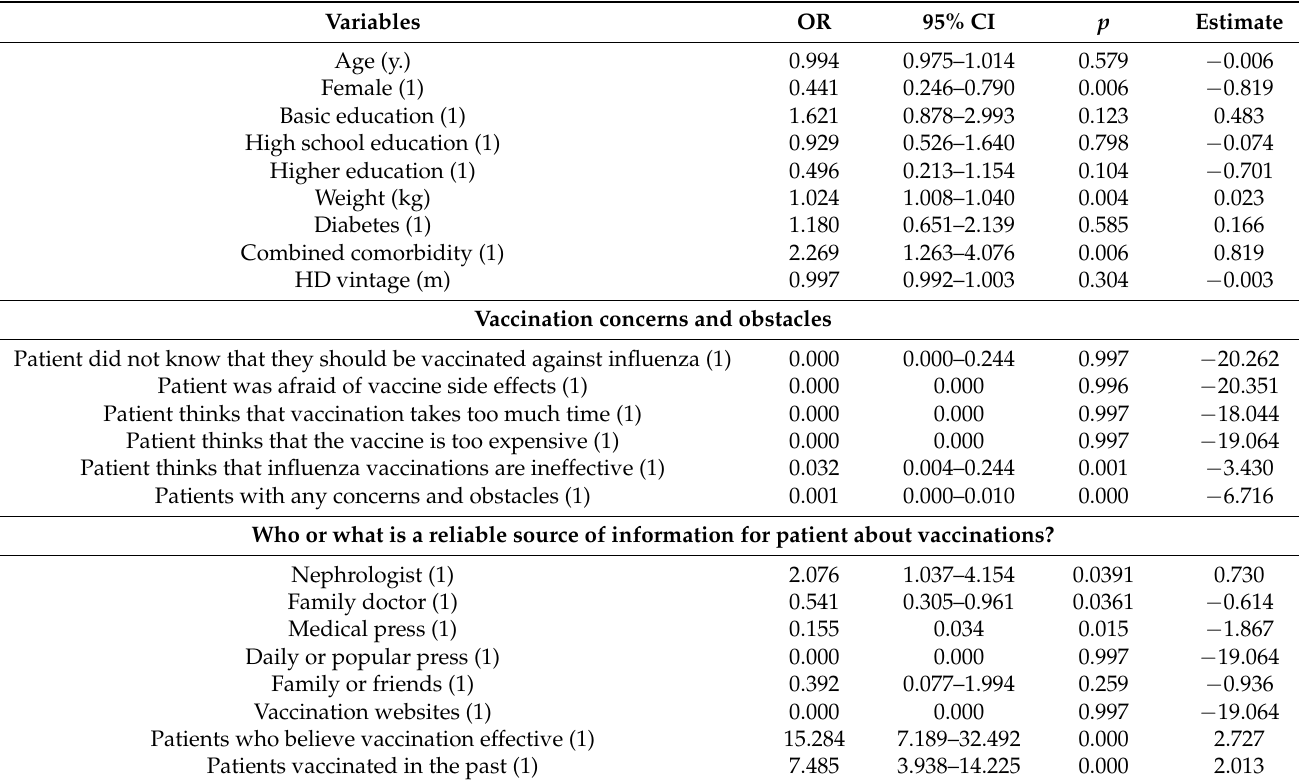
Table 3. Univariate logistic regression. Variables correlated to vaccination status (patients regularly, annually vaccinated against